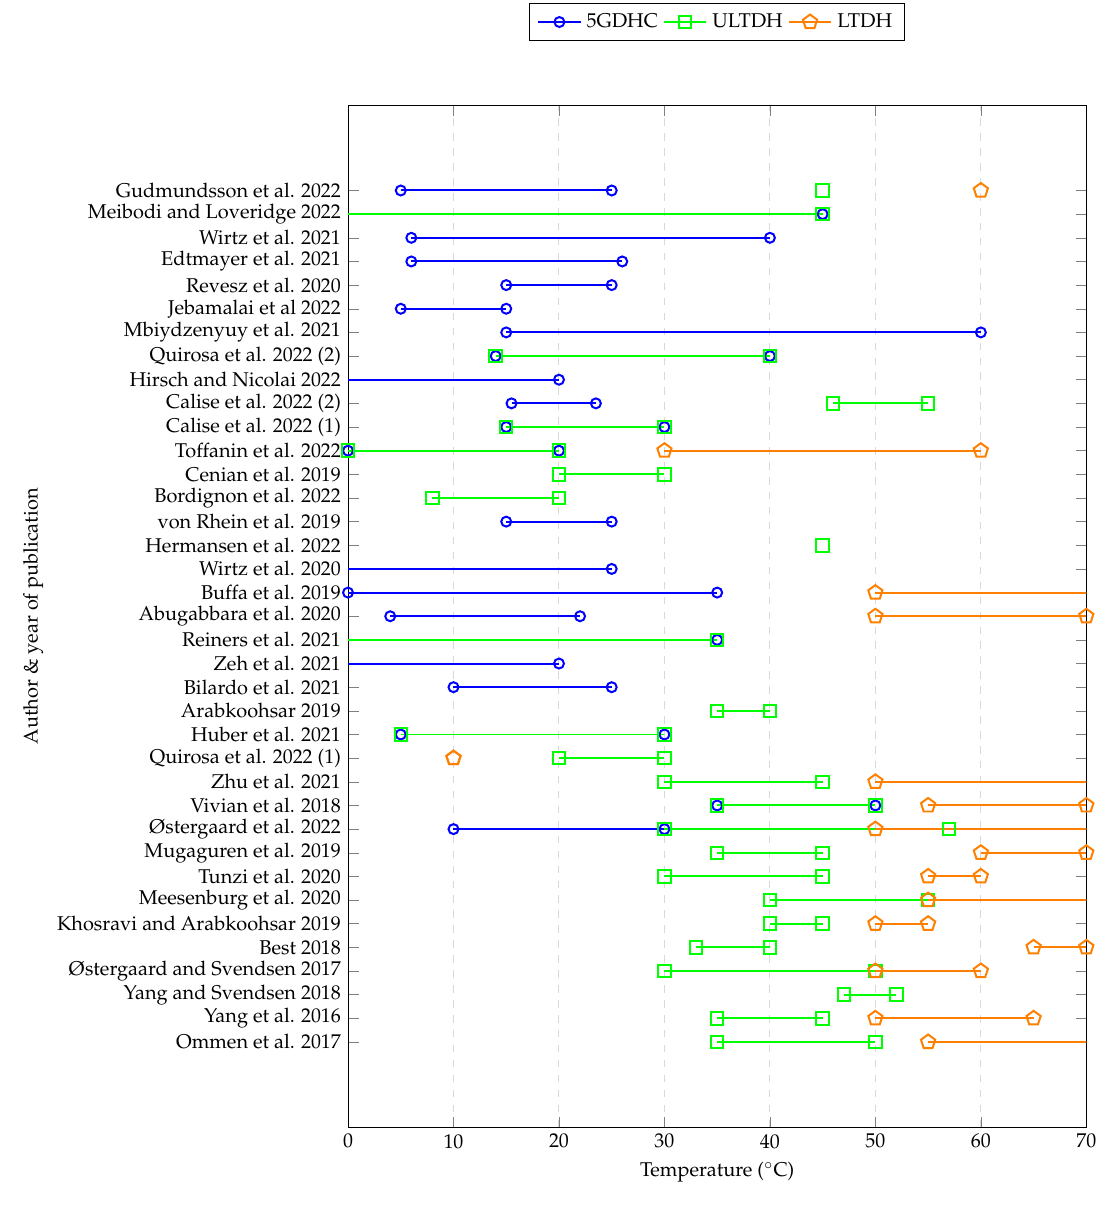
Figure 10. Summary of temperature levels in different category in the literature